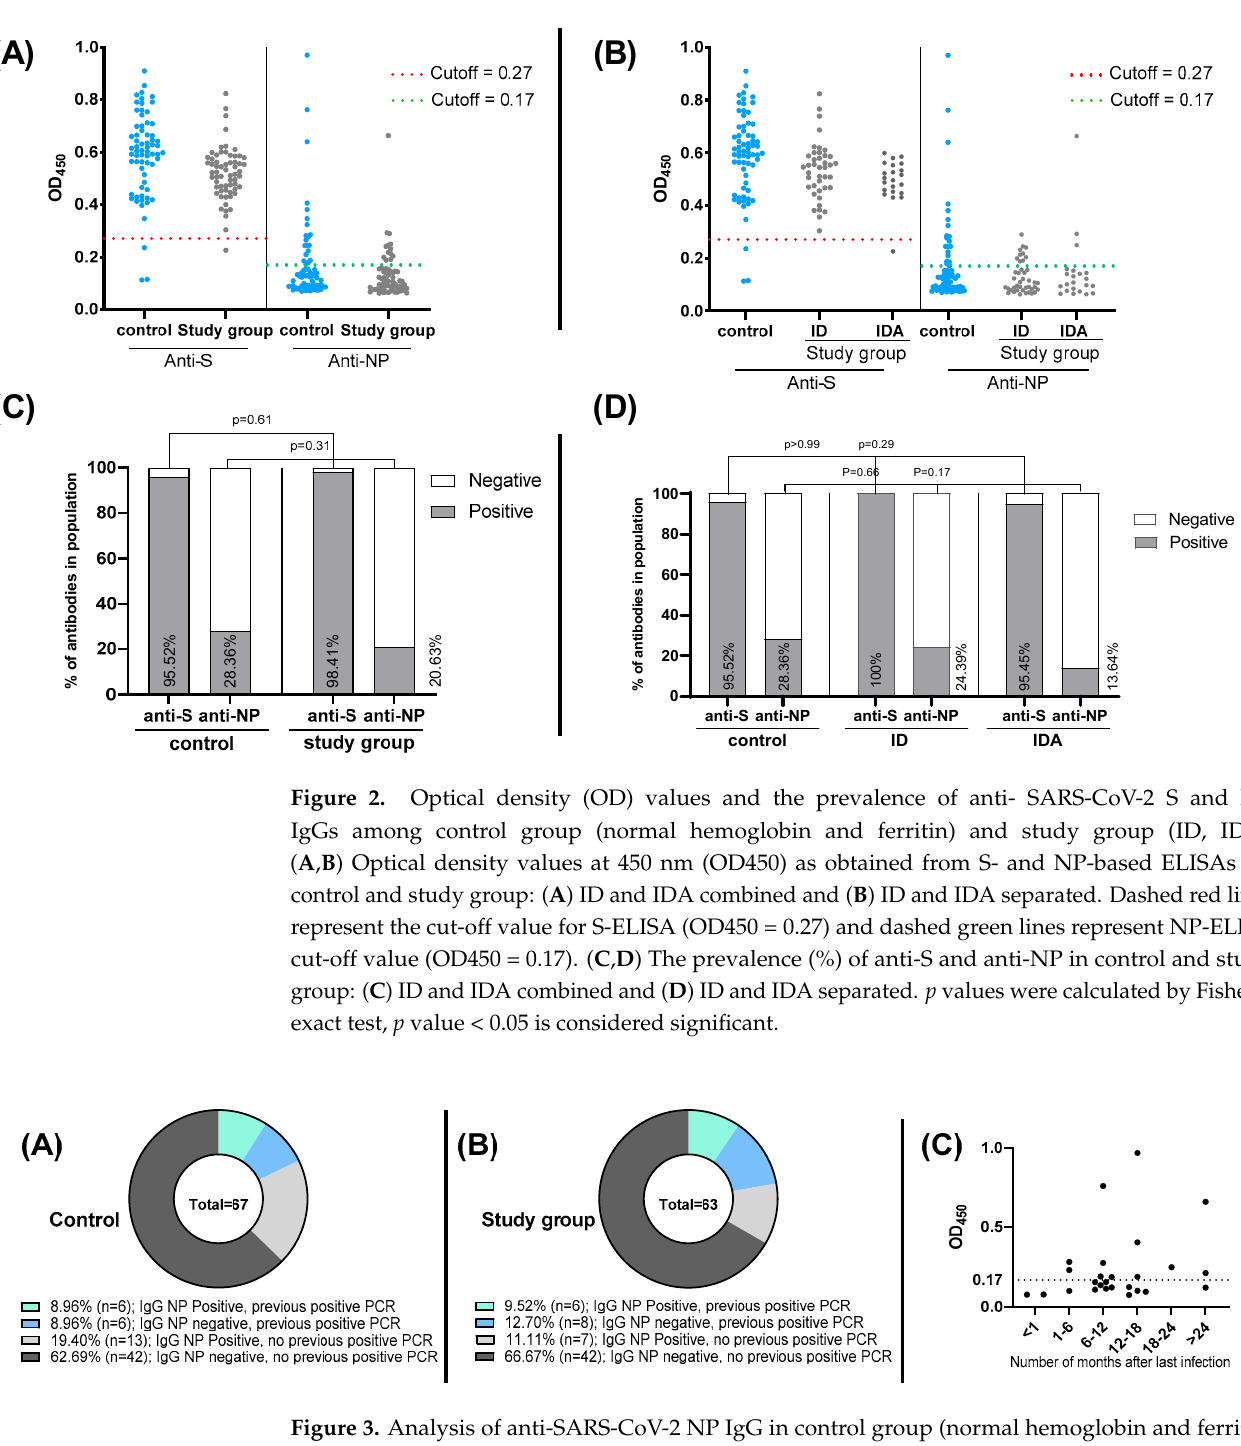
95% CI = 0.6609 to 3.467). Our findings remained consistent whether data from ID and IDA participants were combined or separated (Figure 2 right and left panels, respectively).